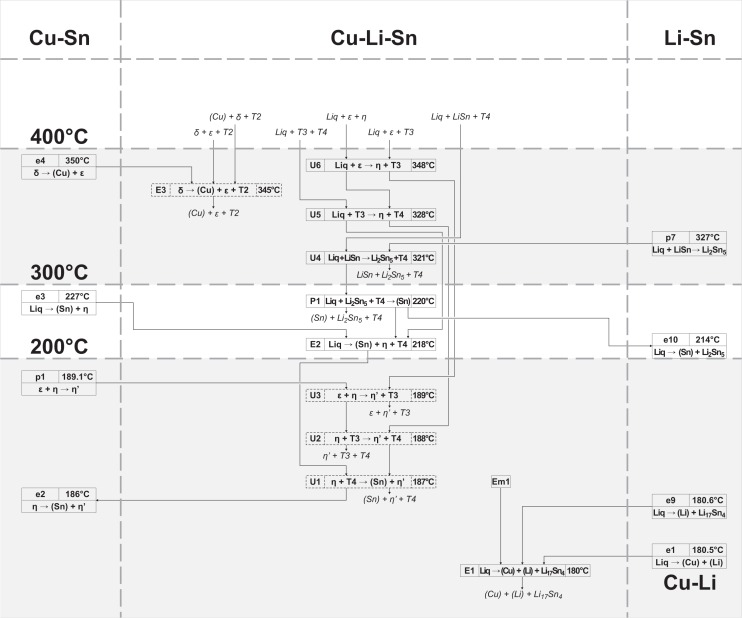
Reaction scheme T < 400°C.